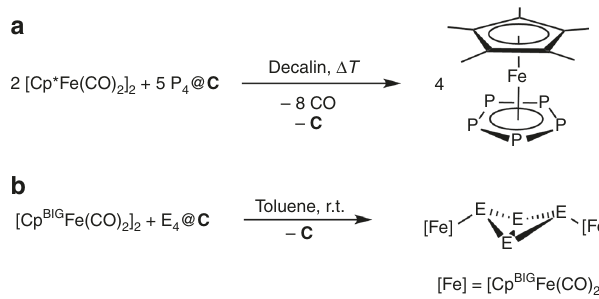
Fig. 3 Reactivity studies. a Synthesis of [Cp*Fe( η 5 -P 5 )]. b Synthesis